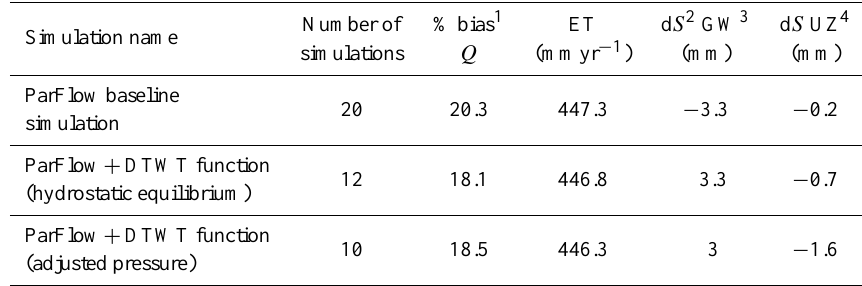
Table 1. Skjern River sub-catchment annual water balance for the equilibrium year after the baseline spin-up approach and the hybrid approach using the hydrostatic equilibrium and adjusted pressure head distribution options above the water table. Annual precipitation is 801.6mm.